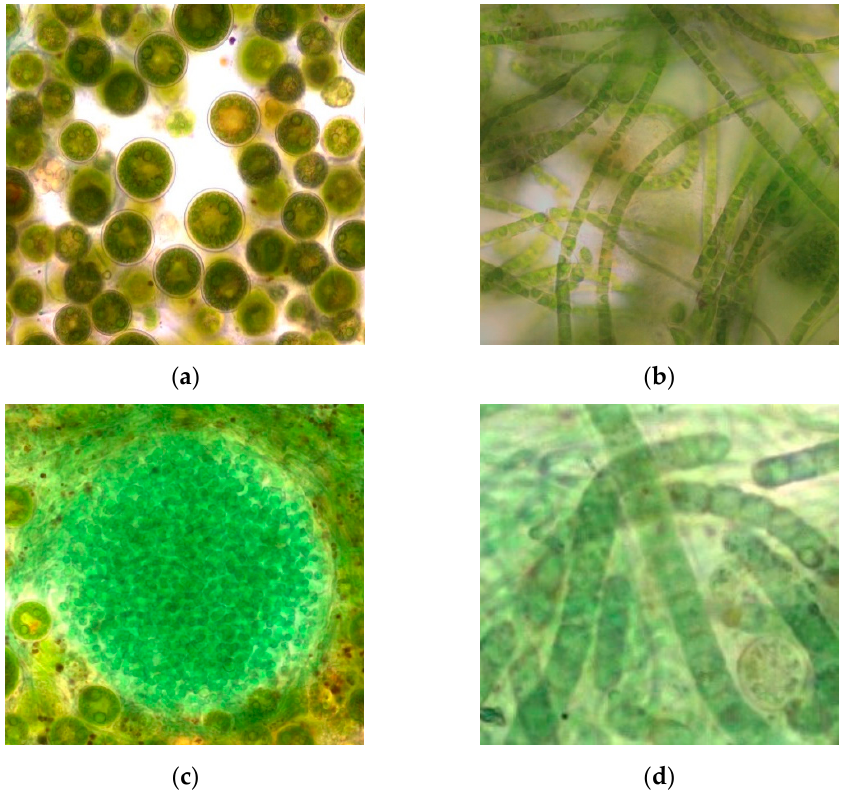
Figure 4. Algal species Hematococcus pluvialis ( a ), Klebsormidium sp. ( b ), cyanobacteria of genus Nostoc ( c ), and Anabaena ( d ). Reprinted from MATEC Web of Conferences, 282, K. Kobeti č ová, J. Náb ě lková, V. Ko č í, Identification of biofilm composition covering lime-based materials, Article No. 20267 (2019), (Licensed under CC BY 4.0) https://creativecommons.org/licenses/by/4.0/.